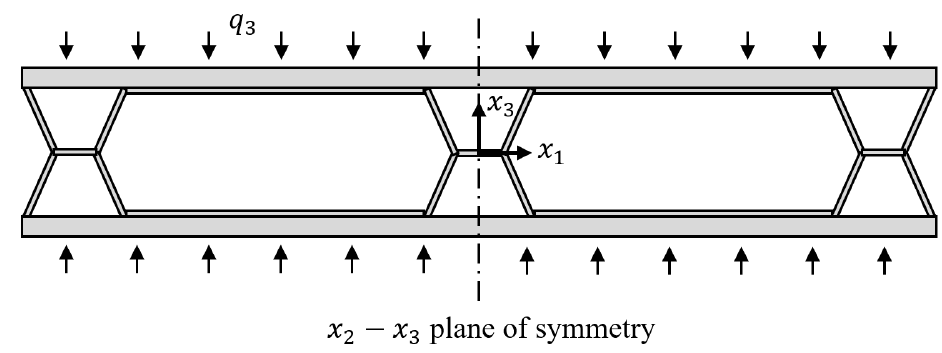
Figure 12. An approximation of the canard cross-section (front-view).